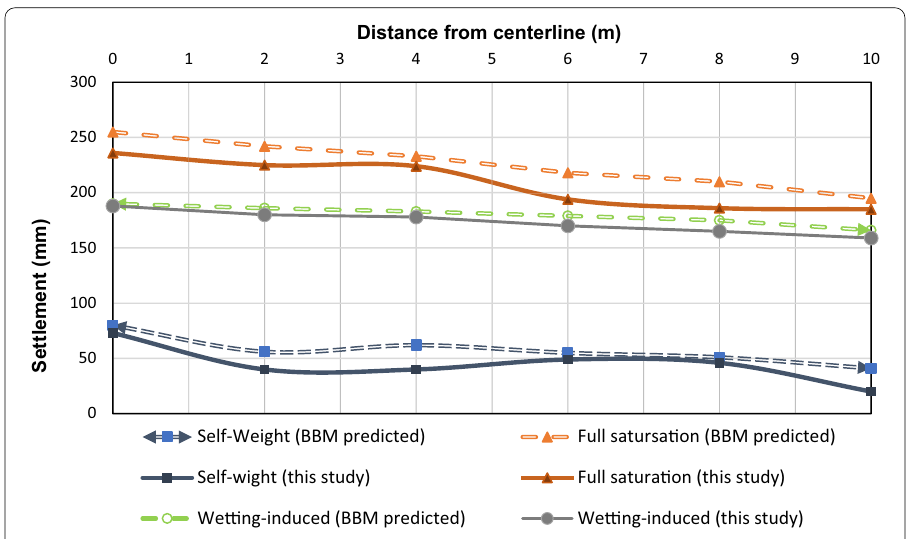
Fig. 6 Comparison of settlements of embankment surface at different distances from